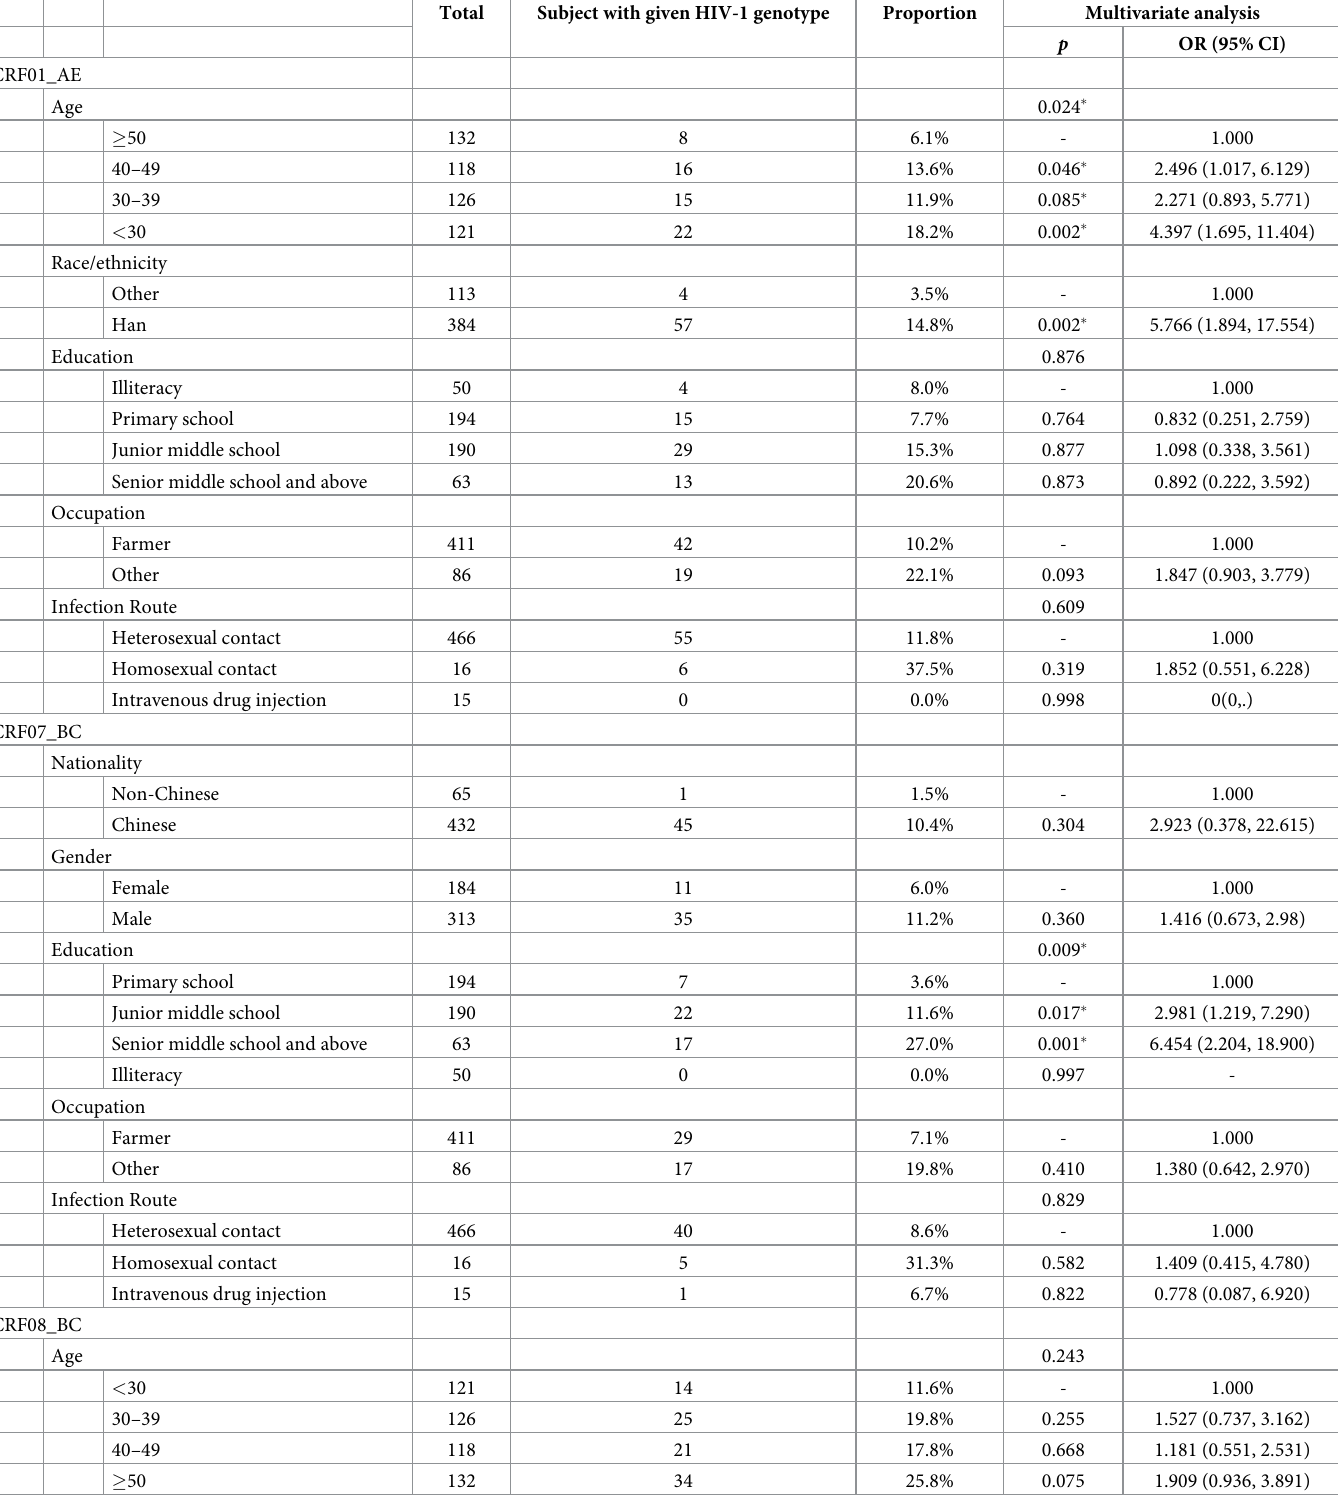
Table 1. Demographic characteristics associated with HIV-1